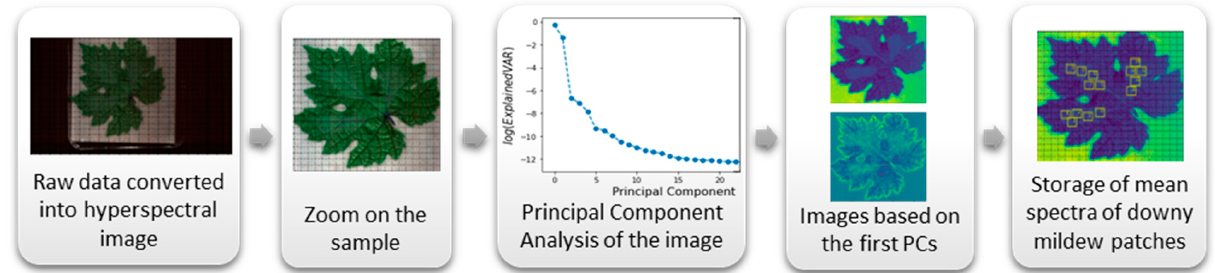
Figure 2. Hyperspectral image processing resulting in a downy mildew patches spectral library. The Principal Component Analysis (PCA) on the zoomed image pixels spectra, computed the percentage of variance carried by each Principal Component (PC). Then, the visualization of the zoomed image projected into the most important PCs subspaces revealed downy mildew on the leaves.